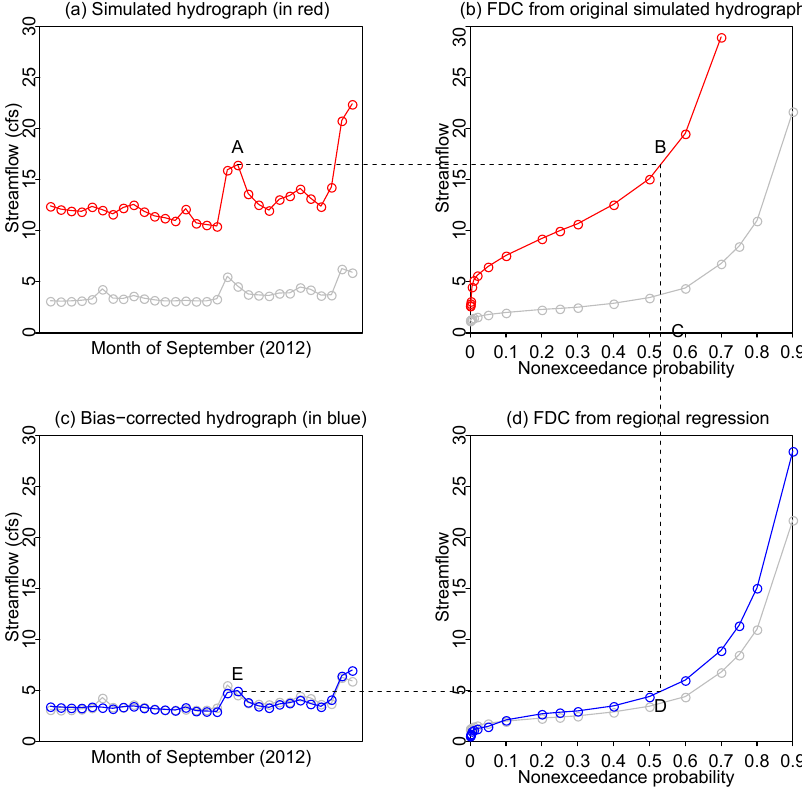
Figure 2. Diagram showing the bias correction methodology applied here. The simulated daily hydrograph at the ungauged site is presented in (a) . For any particular point on the hydrograph (point A) the daily volume of streamflow can be mapped to a nonexceedance probability using the rank order of simulated streamflows (points B and C). With an independently estimated flow duration curve (FDC) from some procedure such as regional regression, the nonexceedance probability can be rescaled to a new volume (point D) and placed back in same sequence as the simulated streamflows (point E) to produce a bias-corrected hydrograph. This example is shown for 1 month, though the FDC applies across the entire period of record. As these data are based on an example site, the observed streamflows and FDC are shown in grey on each